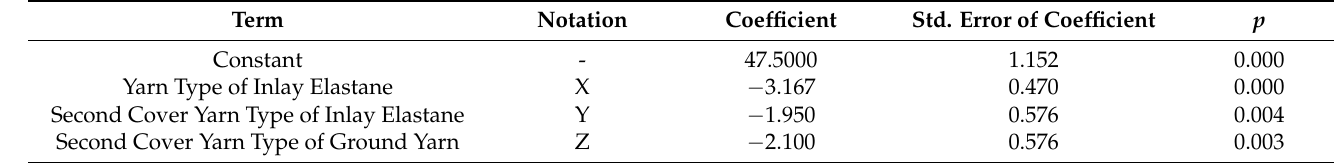
Table 5. Estimated effects of the variables on compression changes.